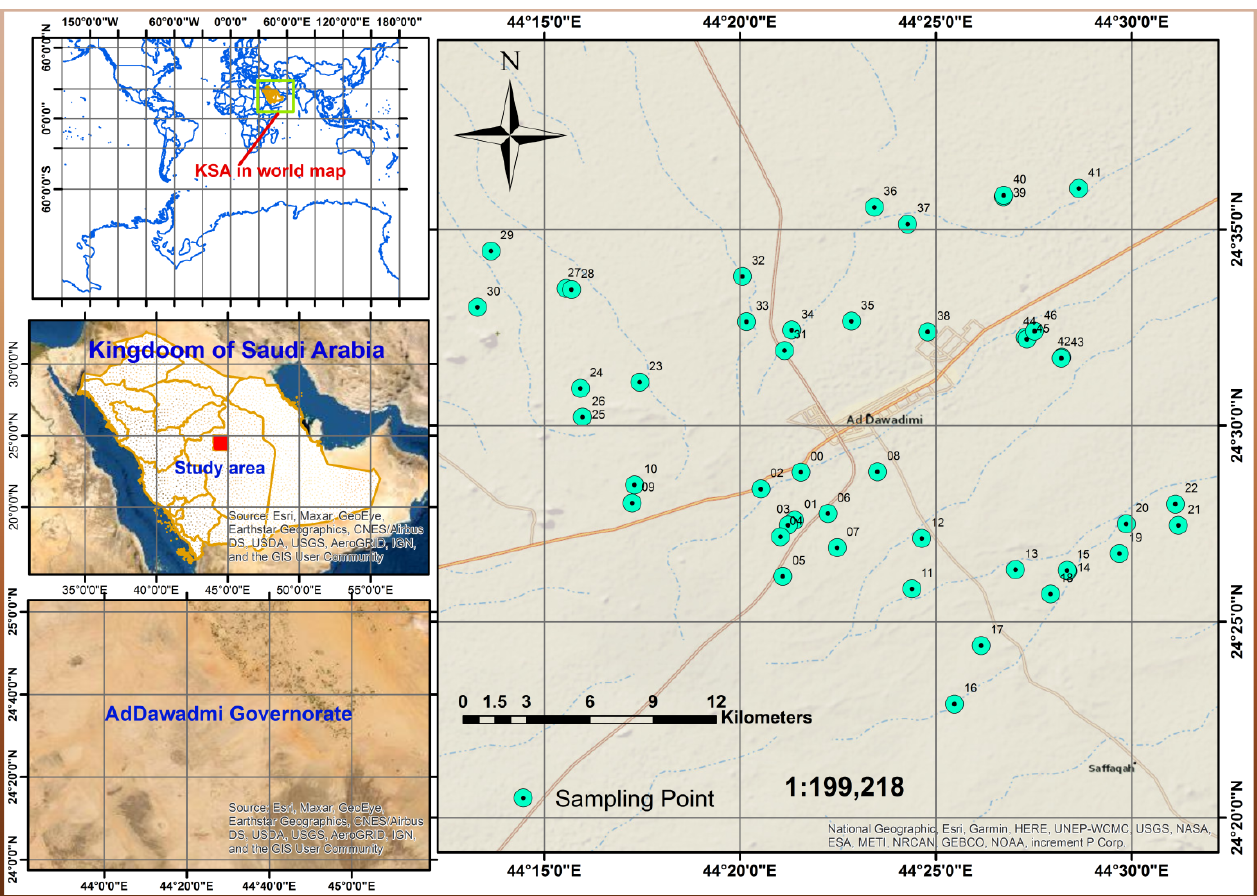
Figure 1. Study area location and the sampling points spatial distribution.